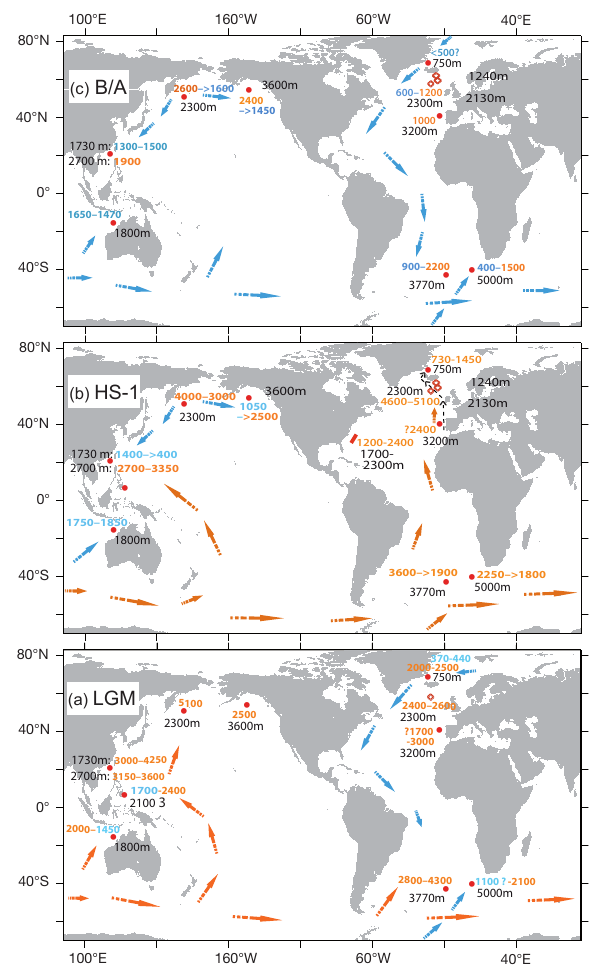
Fig. 7. Ranges of past 14 C ventilation ages (rounded) and tenta- tive simplified circulation patterns below 1500mw.d. (Sarnthein, 2011, modified). Arrows are not based on real data, but on highly simplified inferences per analogy to Fig. 1, based on a hypothe- sis of the ocean’s circulation geometry and emanating from local benthic 1 14 C minima. In the Atlantic and off New Zealand, the ar- rows partly reflect gradients displayed in δ 13 C transects for the Last Glacial Maximum (LGM), Heinrich-Stadial 1 (HS-1), and Bølling– Allerød (B/A) (Curry and Oppo, 2005; McCave et al., 2008; Sarn- thein et al., 1994). Core locations and data sources are listed in Table 1. Orange values and arrows mark waters with ventilation ages higher than today, blue values and arrows present waters with ages equal or lower than today (Fig. 1). Intersecting arrows indi- cate Antarctic-source abyssal waters spreading below deep-ocean waters. Question marks earmark age estimates based on disputable dating techniques and/or indirect evidence (Table 1b and Supple- ment #8). Hatched black arrows mark potential current of interme- diate waters during HS-1. Red diamonds in the northeastern North Atlantic show three sites with a composite 1 14 C record (Thornalley et al.,